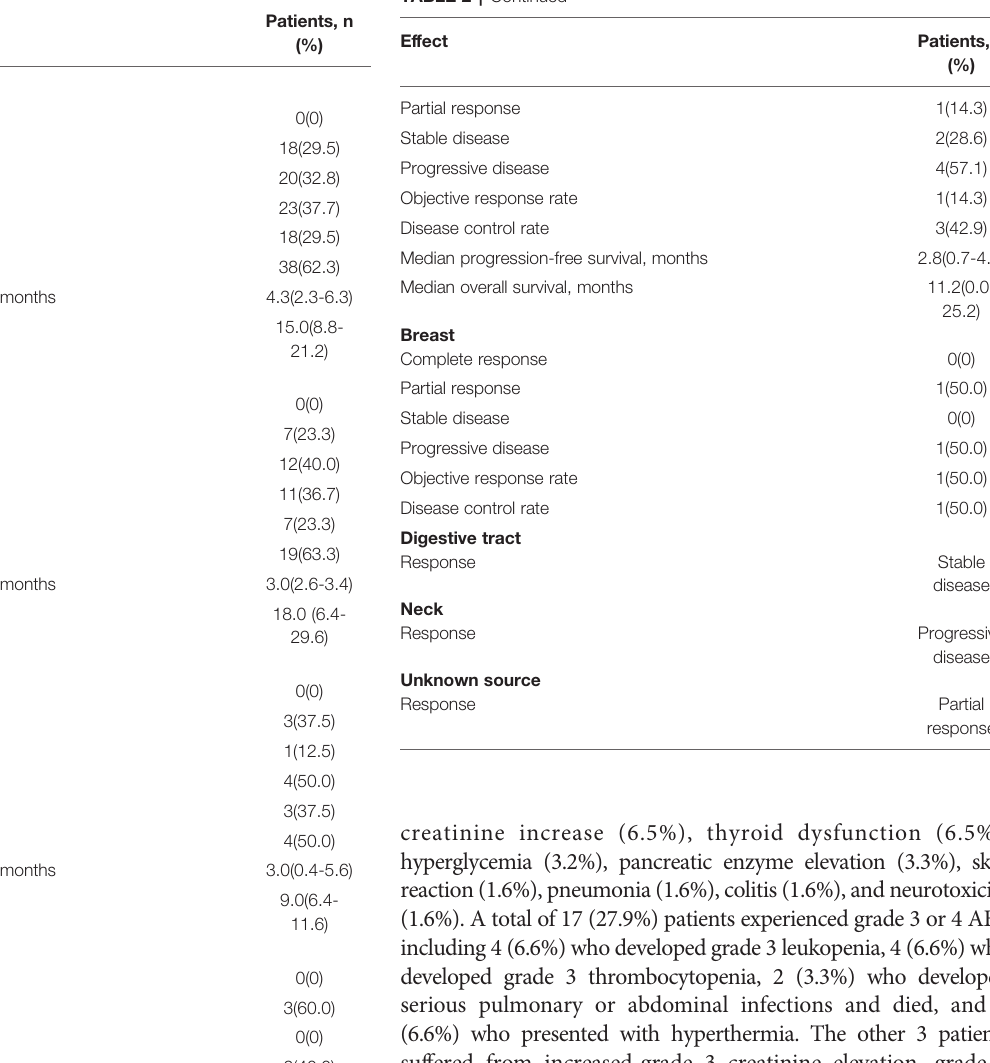
TABLE 2 | Response and survival